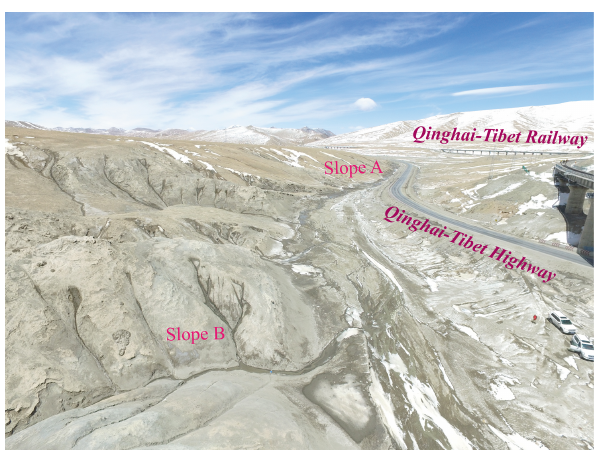
Figure D1. Slopes A and B, with the QTH and QTR clearly visible.